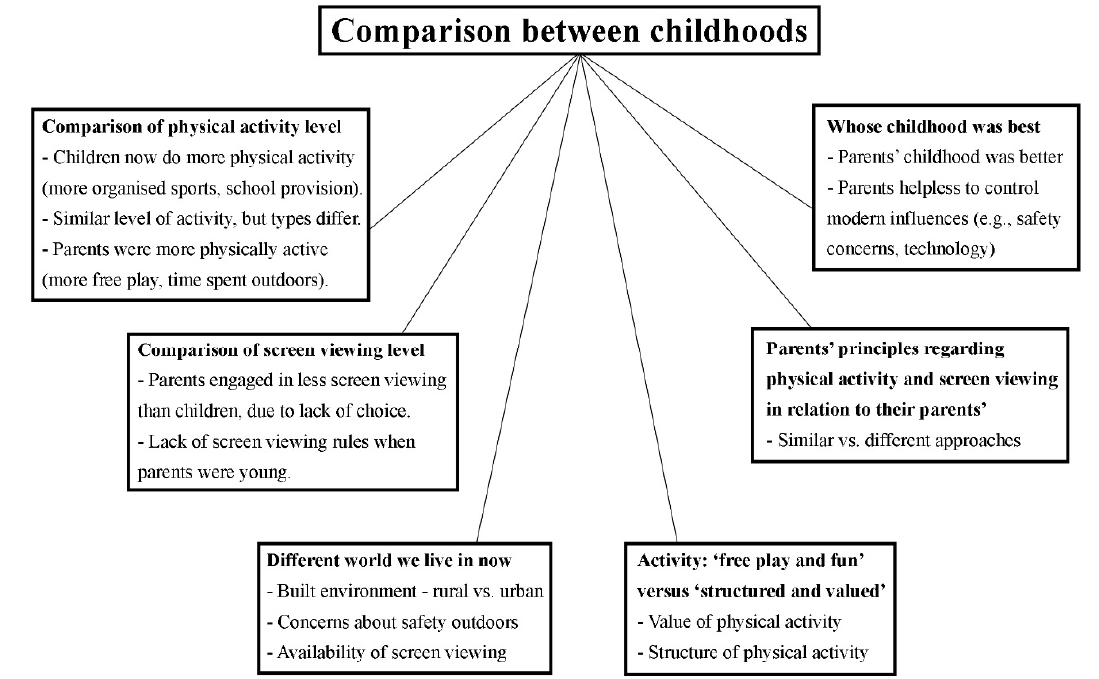
Figure 2. Presentation of the main themes and subthemes.